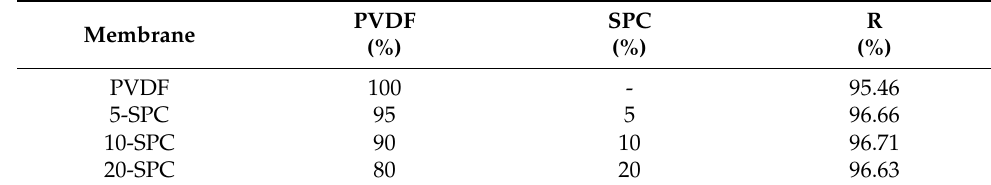
Table 2. The Weight percent relation SPC/PVDF and its oil rejection coefficient for the membranes. Reprinted/Adapted with permission from ref. [32]. © 2008 Elsevier B.V.